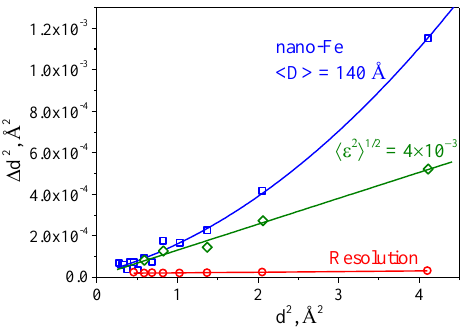
Figure 2. Typical dependences of  d 2 ( d 2 ) demonstrating contributions to the diffraction peak width Figure 2. Typical dependences of ∆ d 2 ( d 2 ) demonstrating contributions to the diffraction peak width Figure 2. Typical dependences of ∆ d 2 ( d 2 ) demonstrating contributions to the diffraction peak width due to isotropic microstrain ε (straight line) and crystallite size 〈 D 〉 (parabolic dependence). due to isotropic microstrain ε (straight line) and crystallite size due to isotropic microstrain ε (straight line) and crystallite size